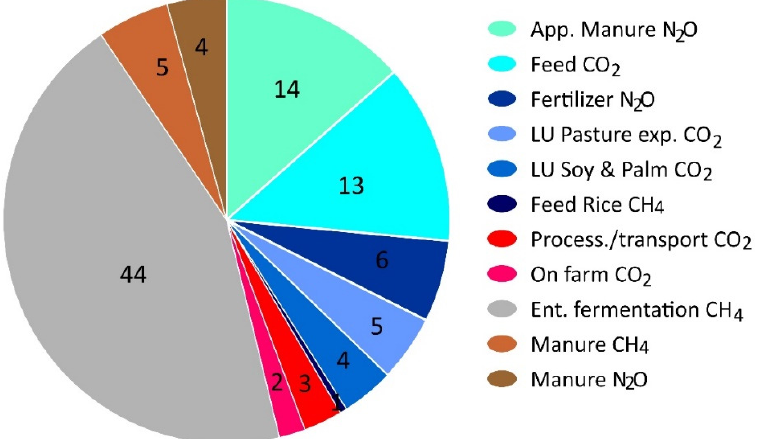
Figure 3. Direct and indirect GHG emissions from livestock by source for different GHGs as a percentage (CO 2e ) (the numbers in each pie slice) [18]. Emissions associated with feed are shown in blue shades and include: application of manure; CO 2 emissions from feed production; land use (LU) including pasture expansion and with soy and palm oil production; CH 4 emissions from rice grown for feed. Emissions related to processing and transport and on-farm energy use are shown in red shades. Gray is used solely for emissions from enteric fermentation and brown shades show emissions related to manure management.